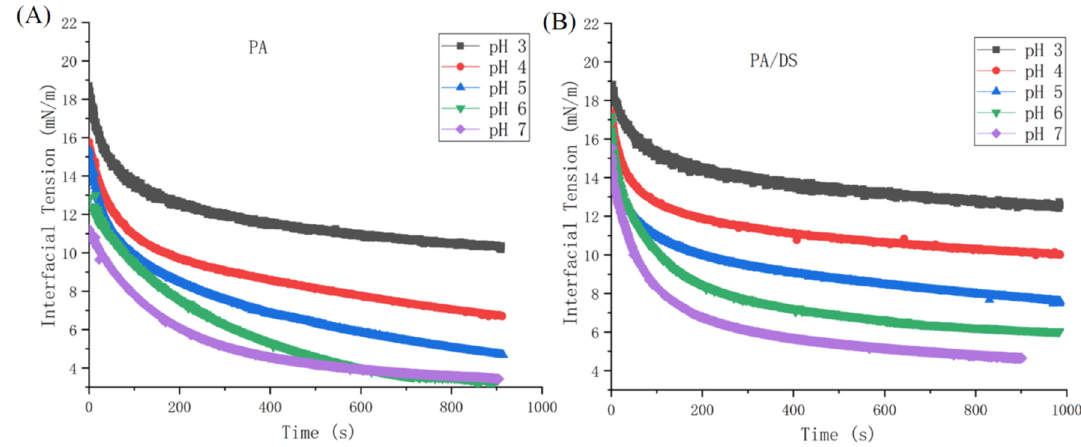
Figure 2. Interfacial tension of PAs ( A ) and PA/DS ( B ) at pH 3–7 as a function of time (s).